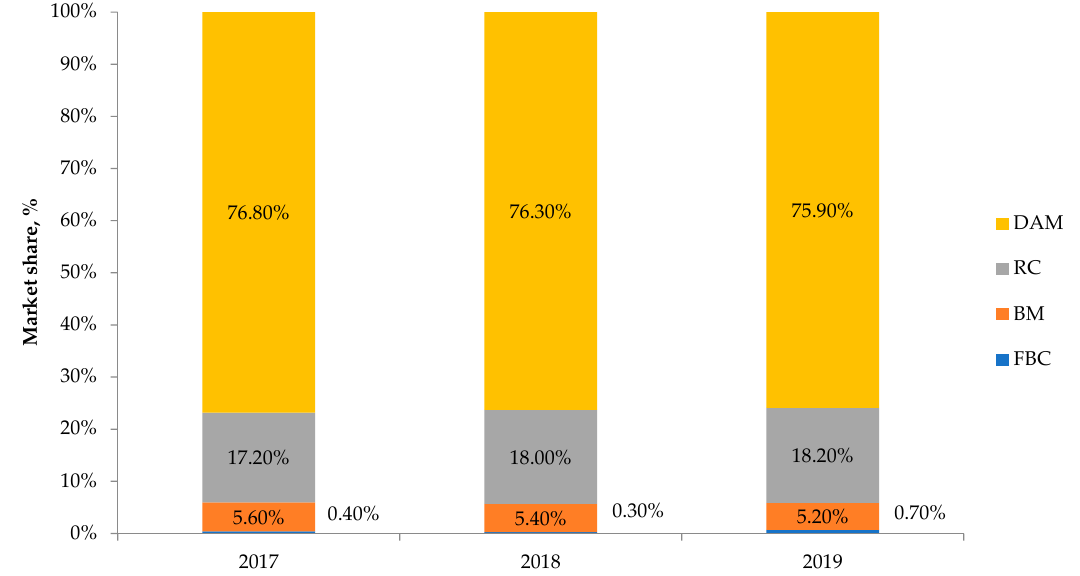
Figure 3. The structure of electricity sales in Russia: the first price zone. Source: own results based on [77]. The weighted average monthly electricity prices formed in the first and second price zones of the wholesale market for 2017–2019 are presented in Figures 5 and